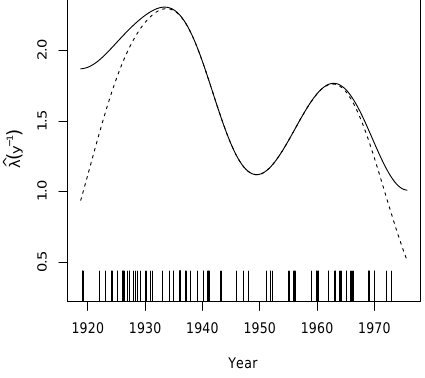
Fig. 4. Estimated flood occurrence rate at S8 – Ponte Juncais, with (solid line) and without (dashed line) pseudodata generation; flood dates (represented by vertical lines) obtained from the POT time data.